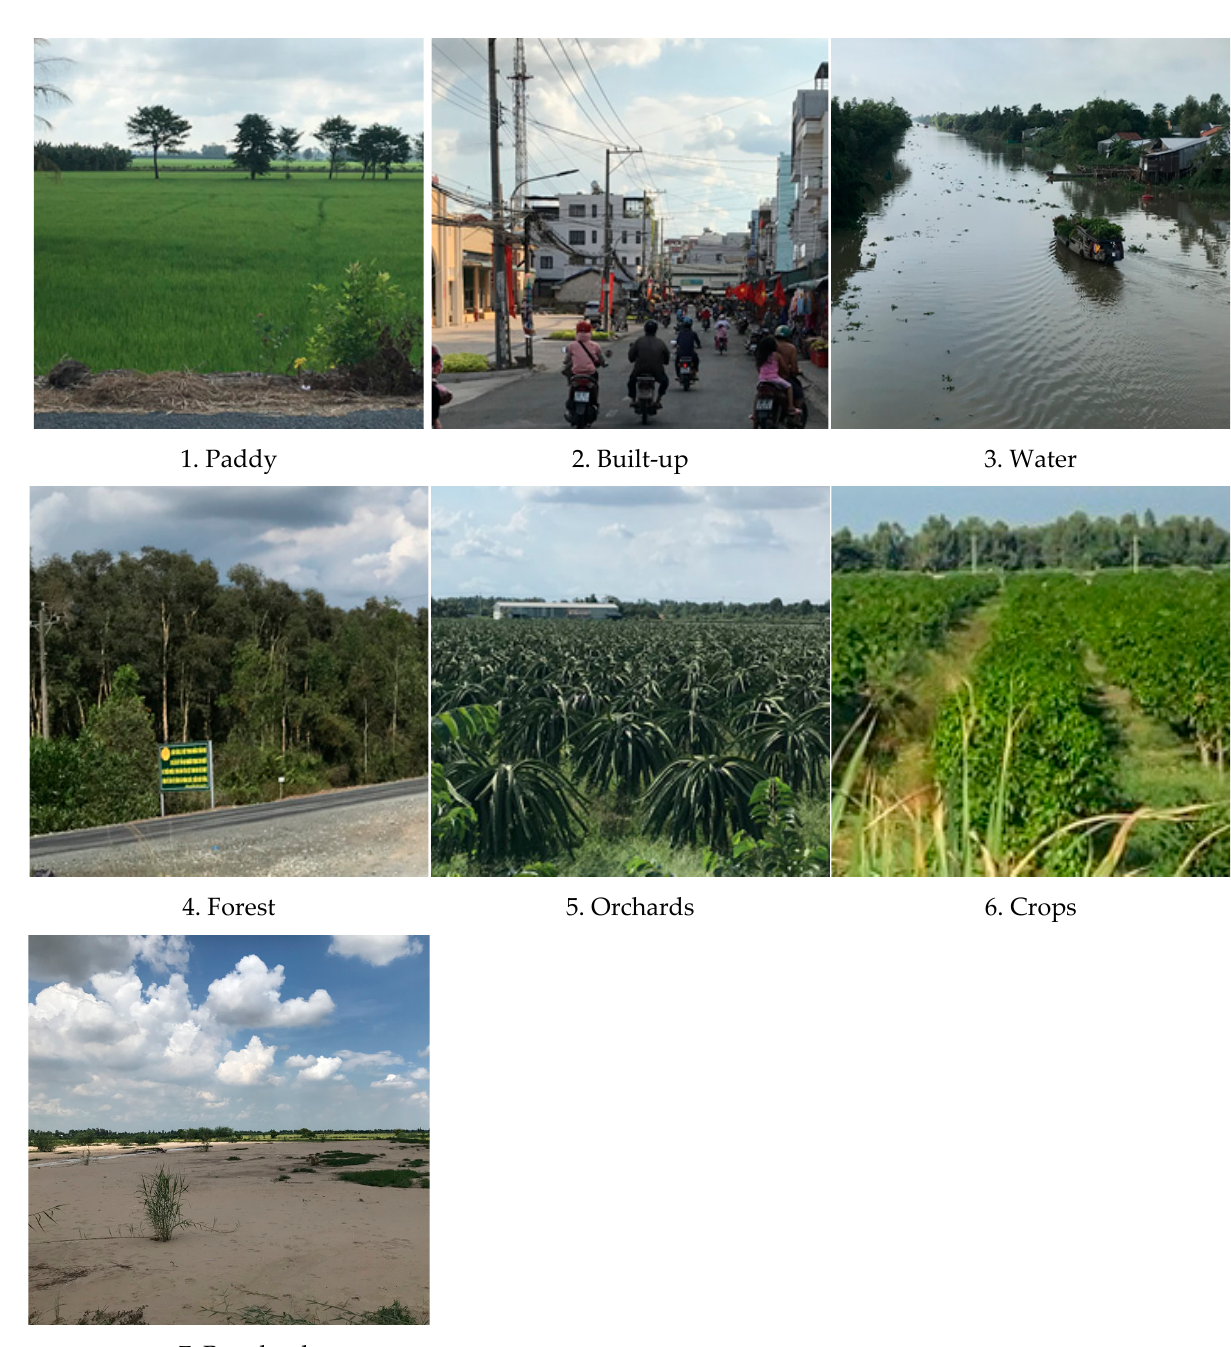
Figure 4. Photos from the field trip in the Dong Thap Muoi area. These photos were taken by Nguyen An Binh and Pham